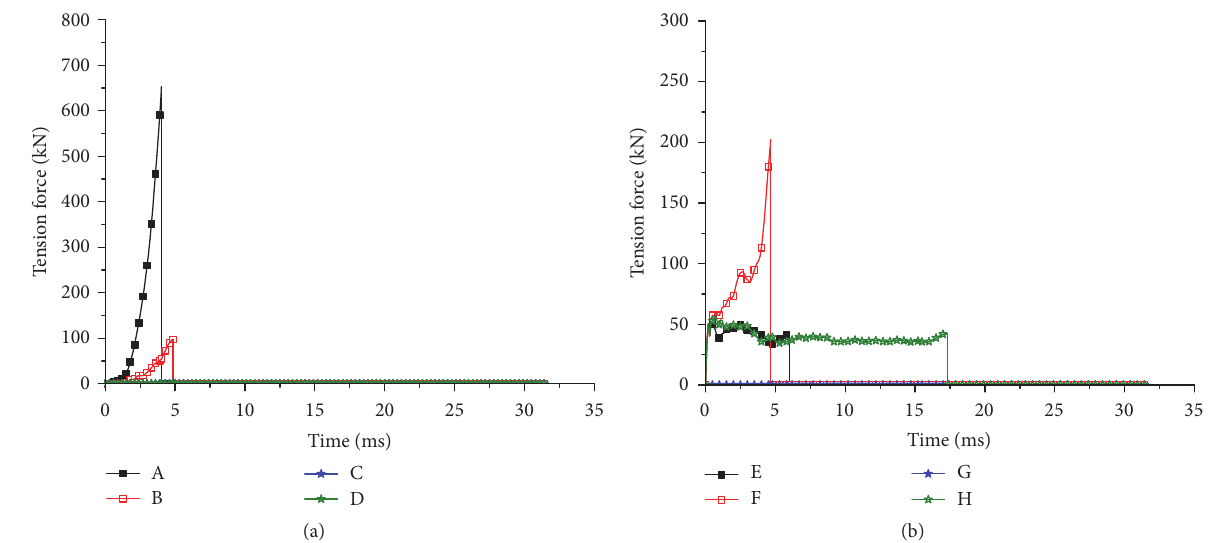
Figure 13: The tensile force time history curves for (a) bolts A, B, C, and D and (b) bolts E, F, G, and H in Model I.